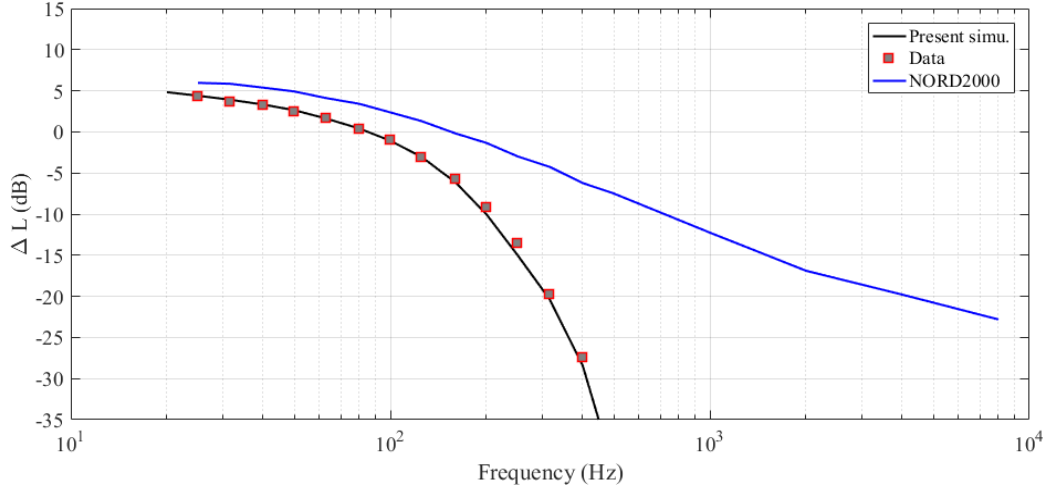
Figure 8. Comparisons of the RSPL in 1/3-octave bands.